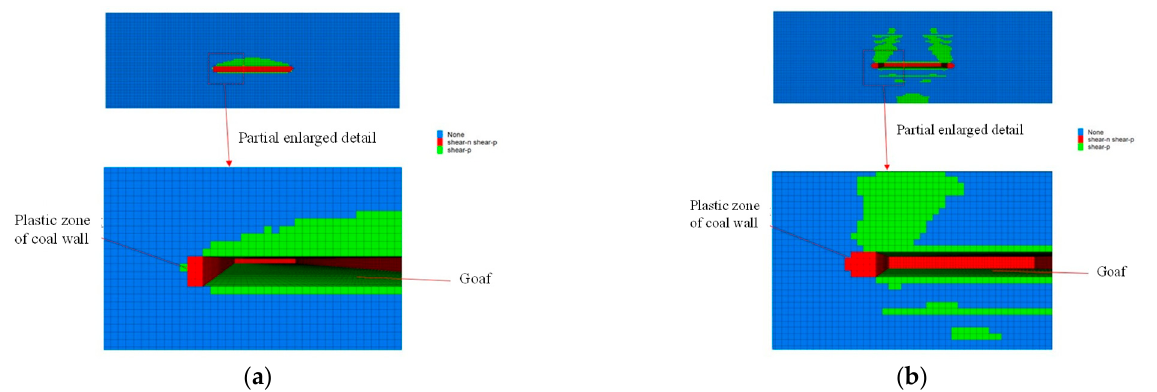
Figure 11. Plastic zone of coal wall before grouting. ( a ) Plastic zone of end coal wall; ( b ) Plastic zone of central coal wall.